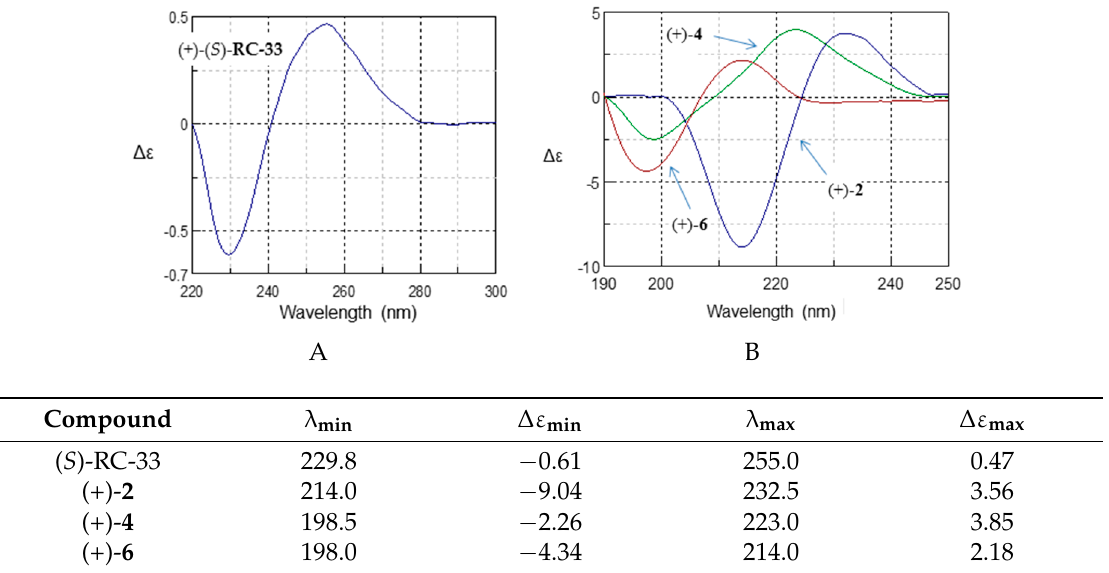
Figure 5. ECD curves of ( A ) (+)-( S )-RC-33, B ) (+)- 2 , (+)- 4 , (+)- 6 and their Cotton effect (CE) in the wavelength range of 190–300 nm.